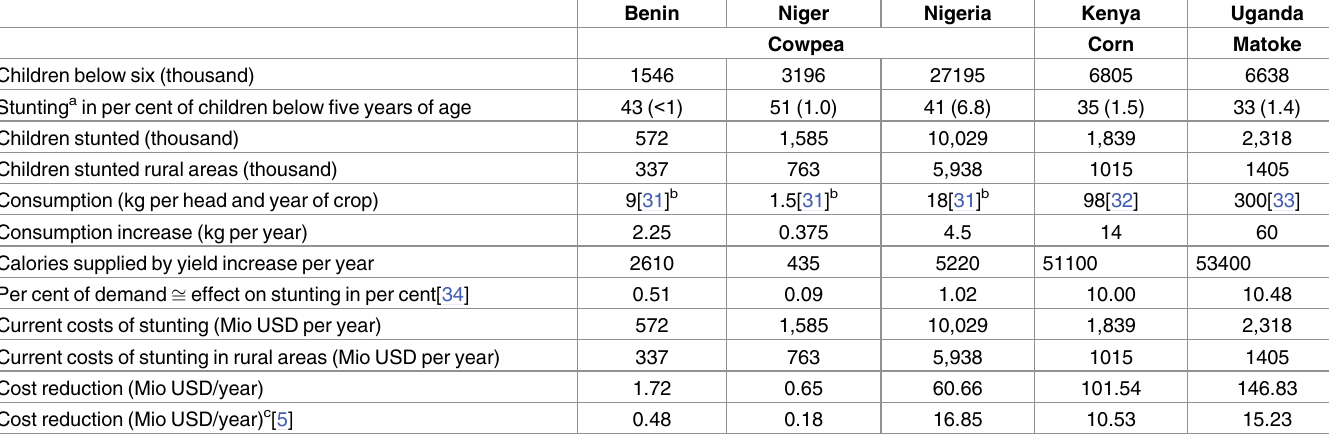
Table 3. Status of malnourishment in Benin, Niger, and Nigeria, Kenya, and Uganda for the year 2011 [30]. Benin Niger Nigeria Kenya